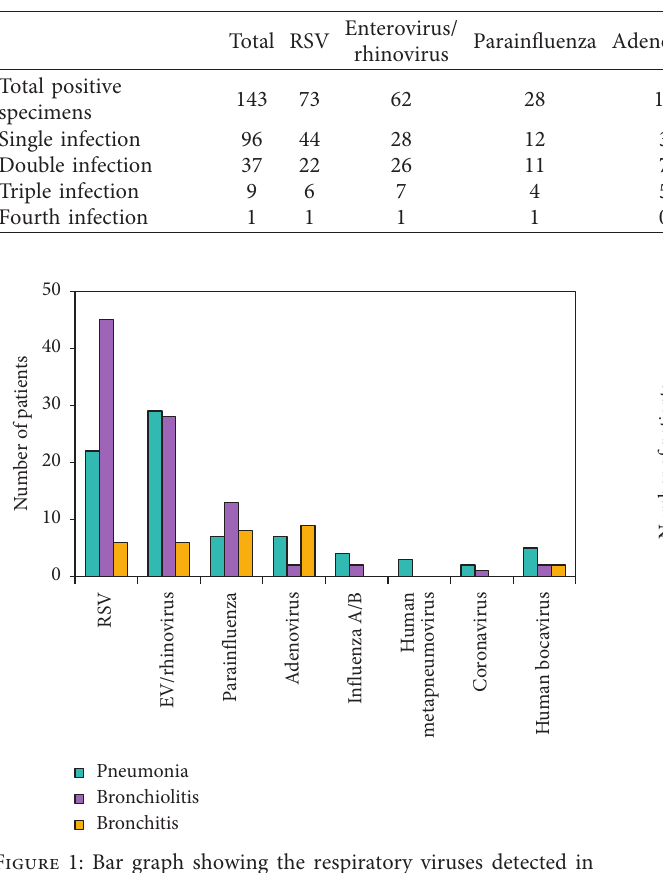
Table 1: Viruses detected in 194 patients with acute respiratory infections using the respiratory viral panel Fast assay.